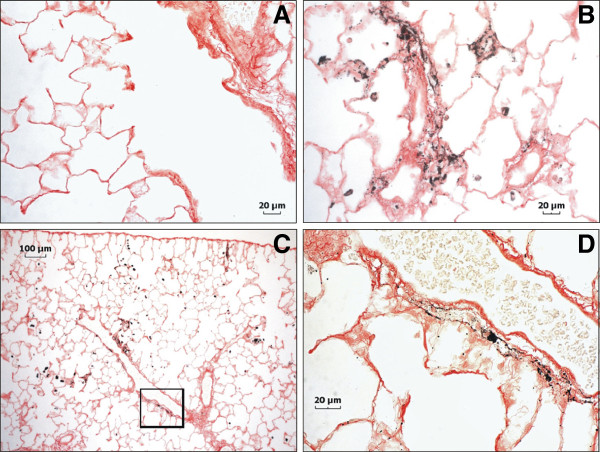
Autometallographic evaluation of tissue distribution of QD 28 days post-exposure. Silver enhancement staining of QD in lung tissue of rats 28 days after intratracheal instillation 12.5 μg of QD-COOH (B-D) or PBS (control) (A): a high magnification micrograph of QD-COOH showing AM clustered around vessels walls (B), a low magnification micrograph of a vessel with QD-COOH in and surrounding areas that may be perivascular lymphatic vessels (C), and several serial sections from the boxed area of Panel C imaged and stacked together at high magnification to illustrate accumulation of QD in and around a possible lymphatic vessel (D).